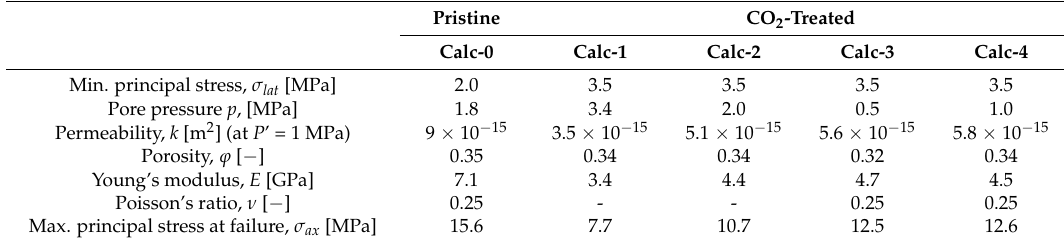
Table 2. Properties of pristine and carbon dioxide (CO 2 ) treated Apulian